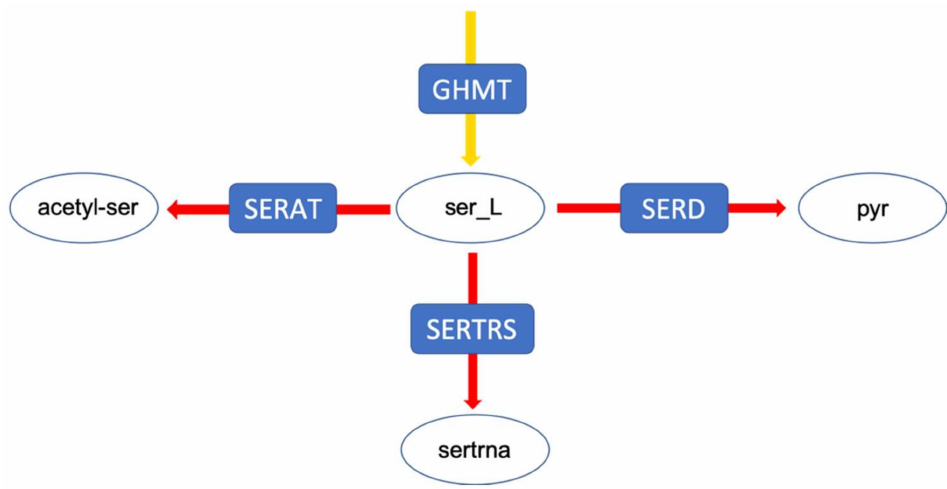
Figure 5. The serine branching point by which serine is distributed. Pyr: pyruvate; sertrna: L-seryl- tRNA; acetyl-ser: Acetyl-serine.